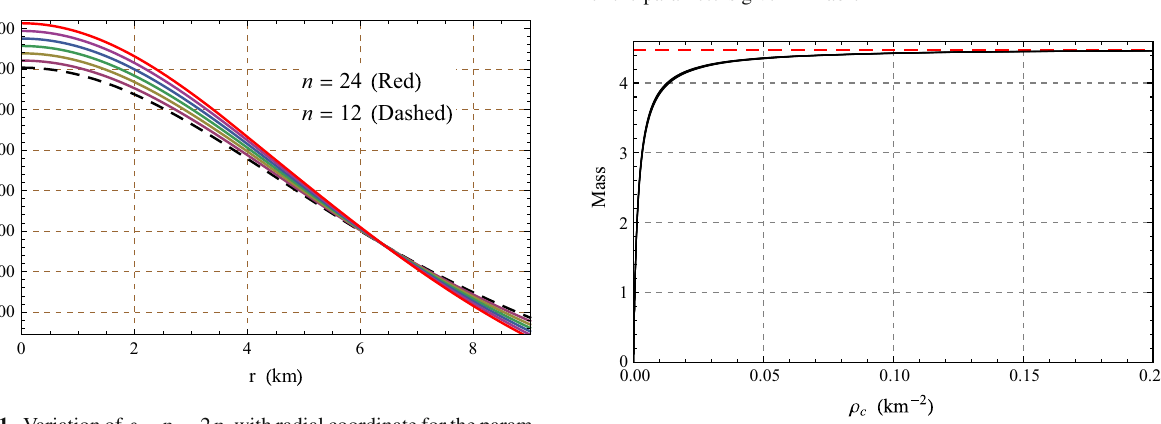
Fig. 13 Variation of relativistic adiabatic index with radial coordinate for the parameters given in Table 1